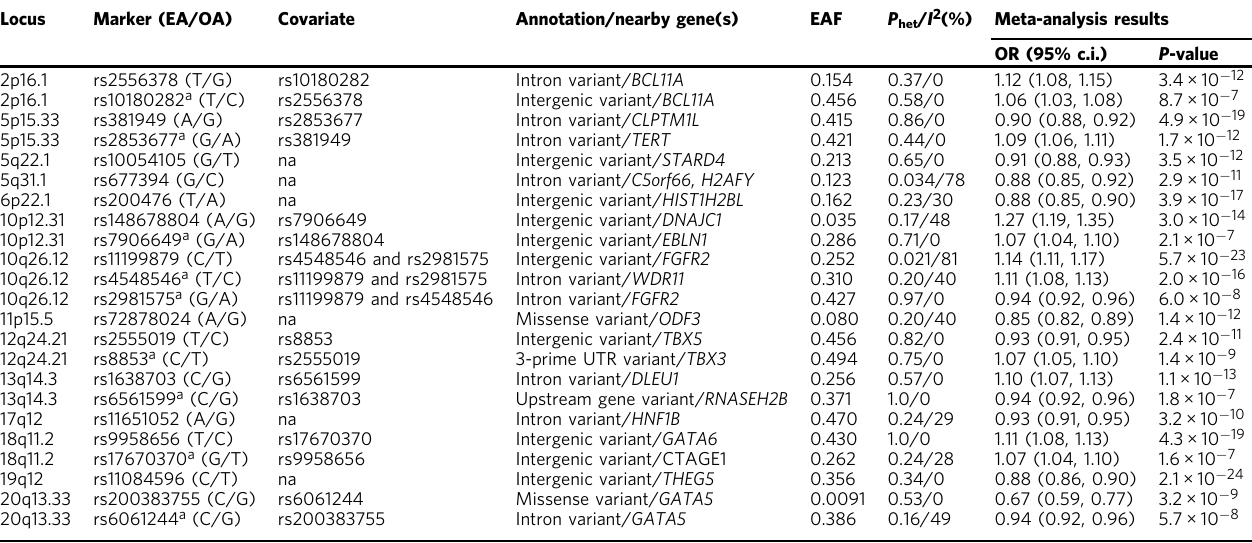
Table 1 Results from the meta-analysis of Icelandic and UK GWAS of symptomatic BPH/LUTS and from the the conditional analysis for loci with multiple variants